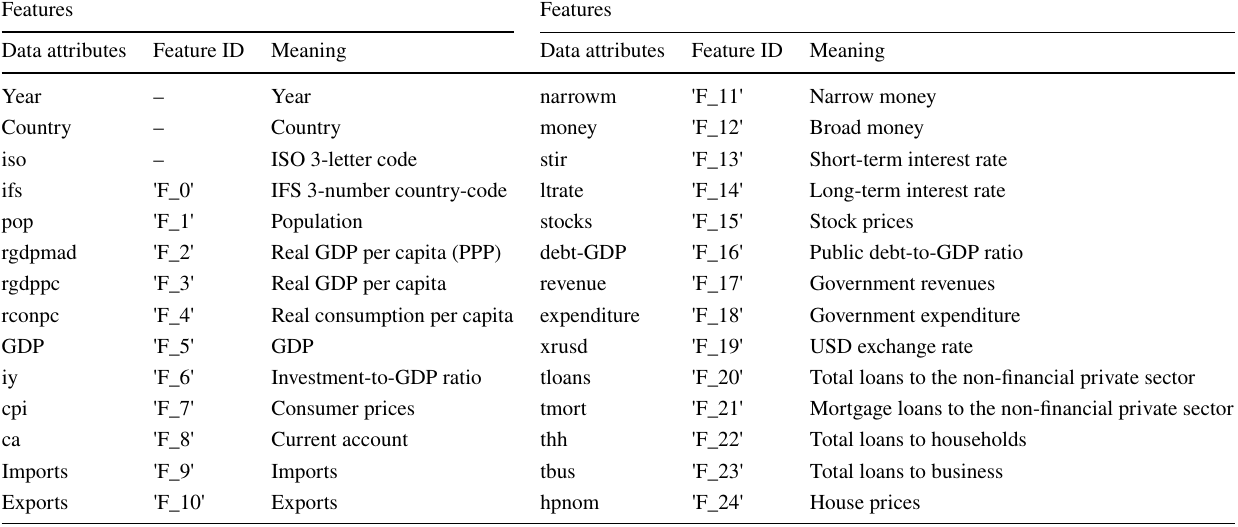
Fig. 7 Confusion matrices of classification results: a) Confusion matrix for Random Forest model, b) confusion matrix for Gradient Boosting model Table 8 The optimized features used to recognize financial crisis roots